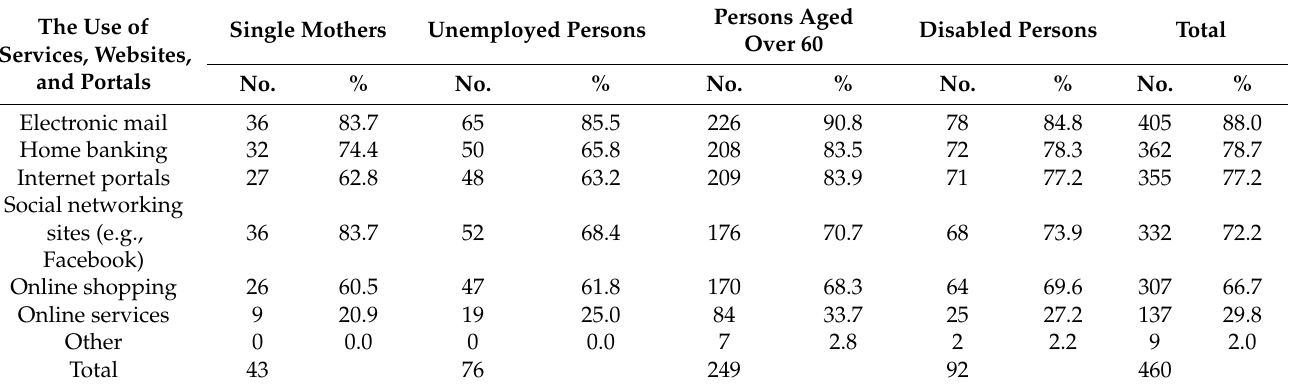
Table 12. The use of services, websites, and internet portals by social status of the respondents ( n =